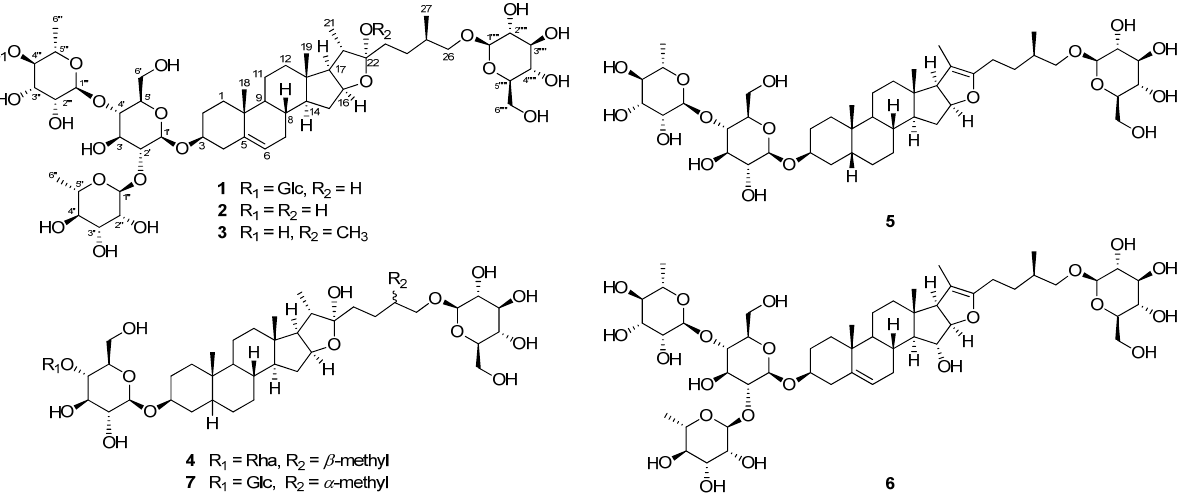
Figure 1. Structures of compounds 1 – 7 isolated from the roots of A. cochinchiensis .